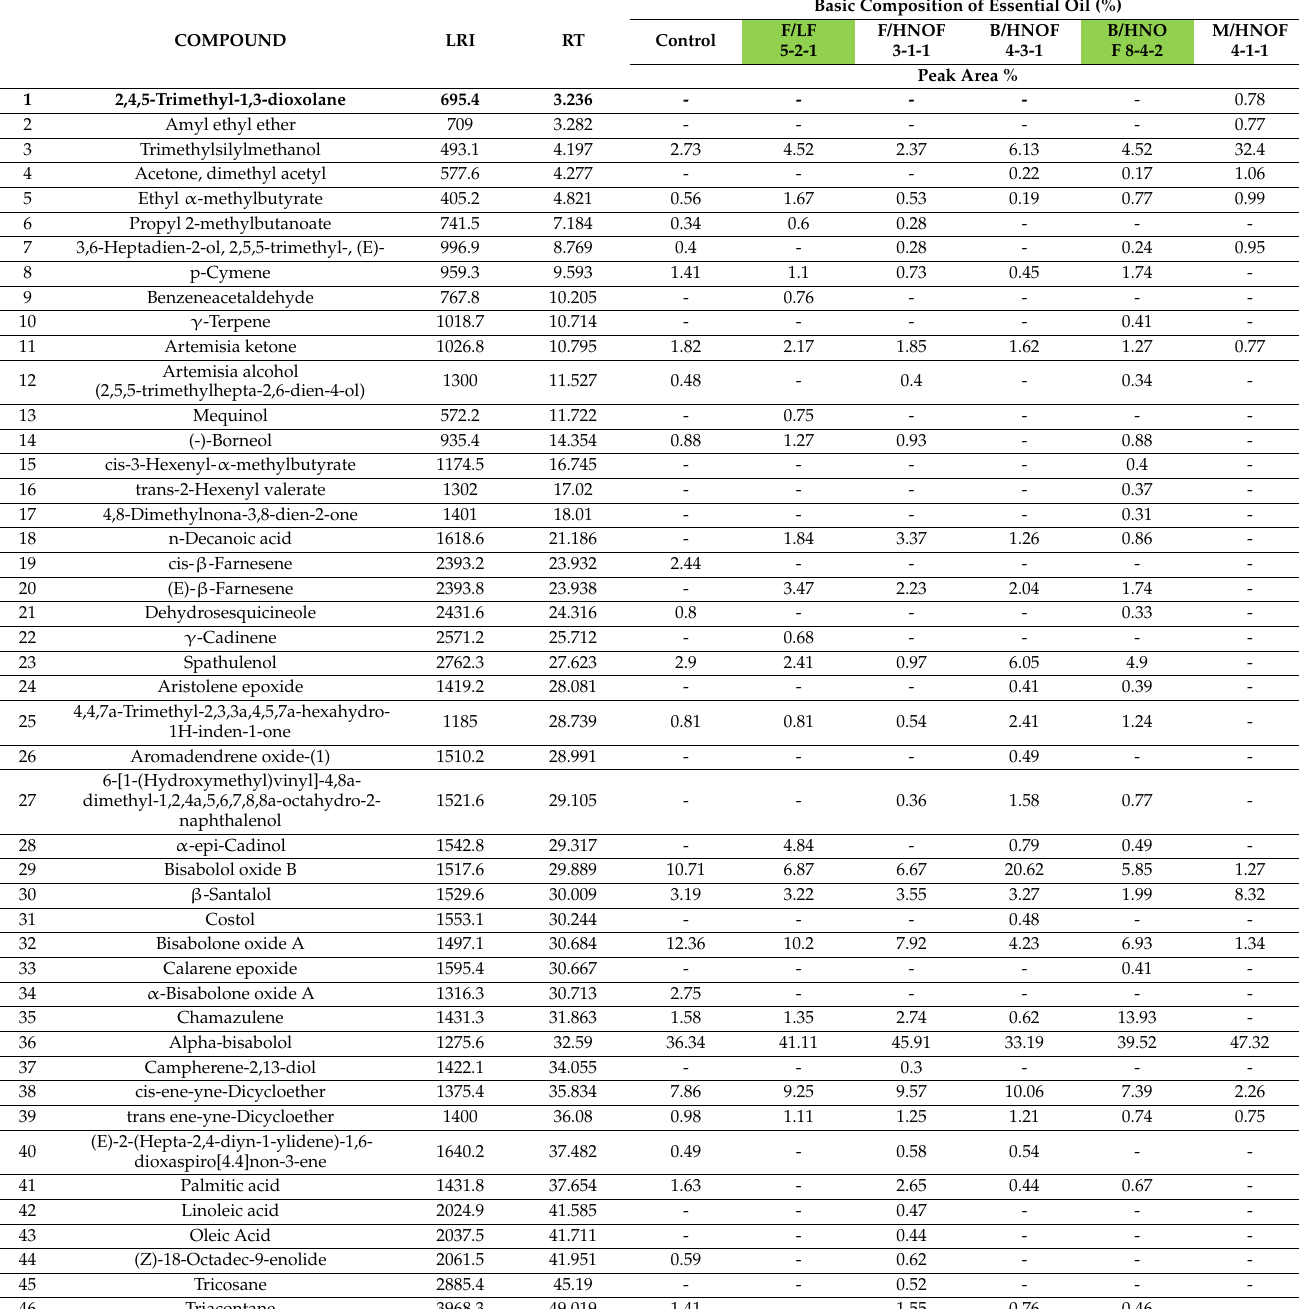
Table 4. GC-MS essential oil composition of the selected five promising M 4